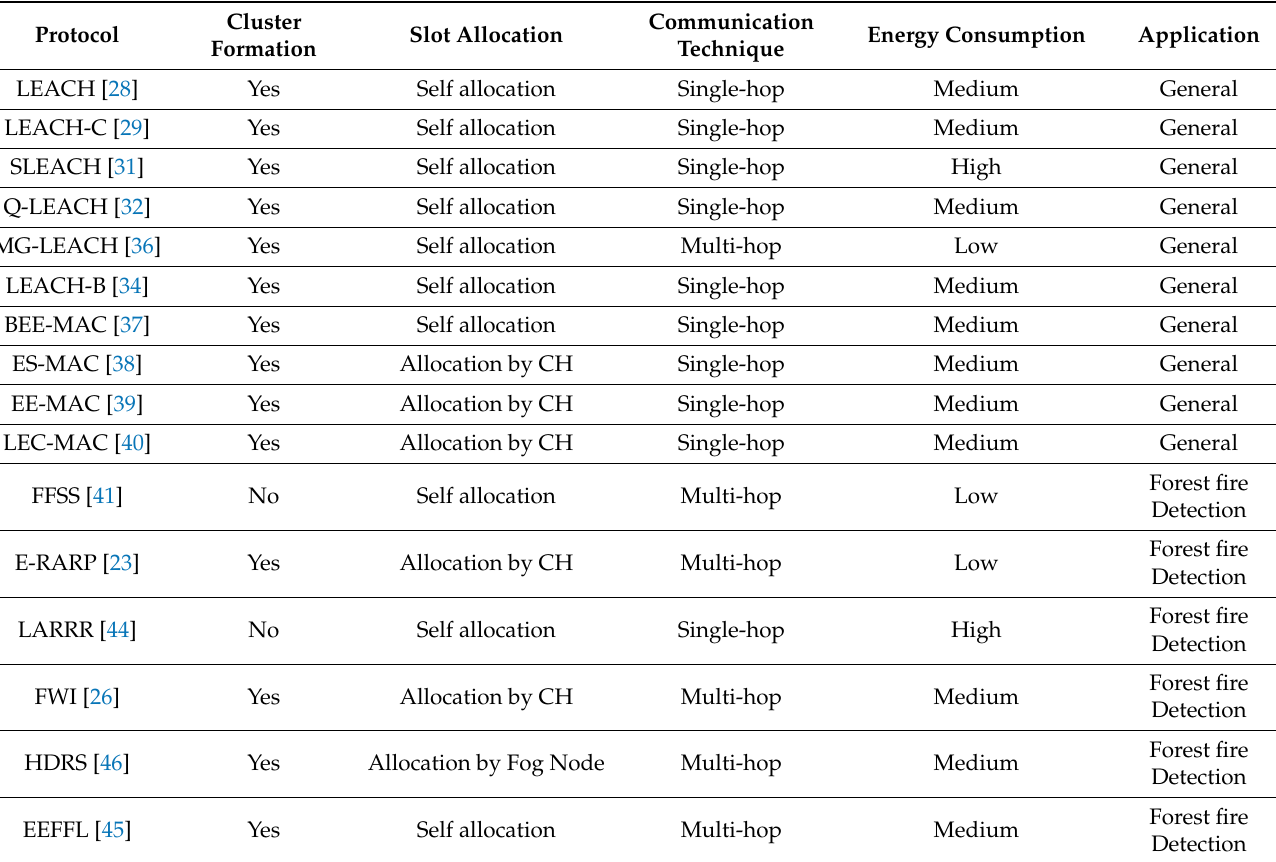
Table 1. Comparison